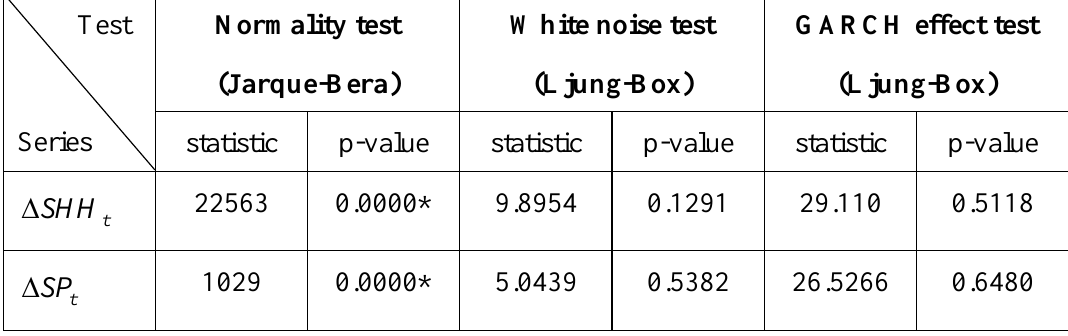
Table 7: Model diagnostic statistics for